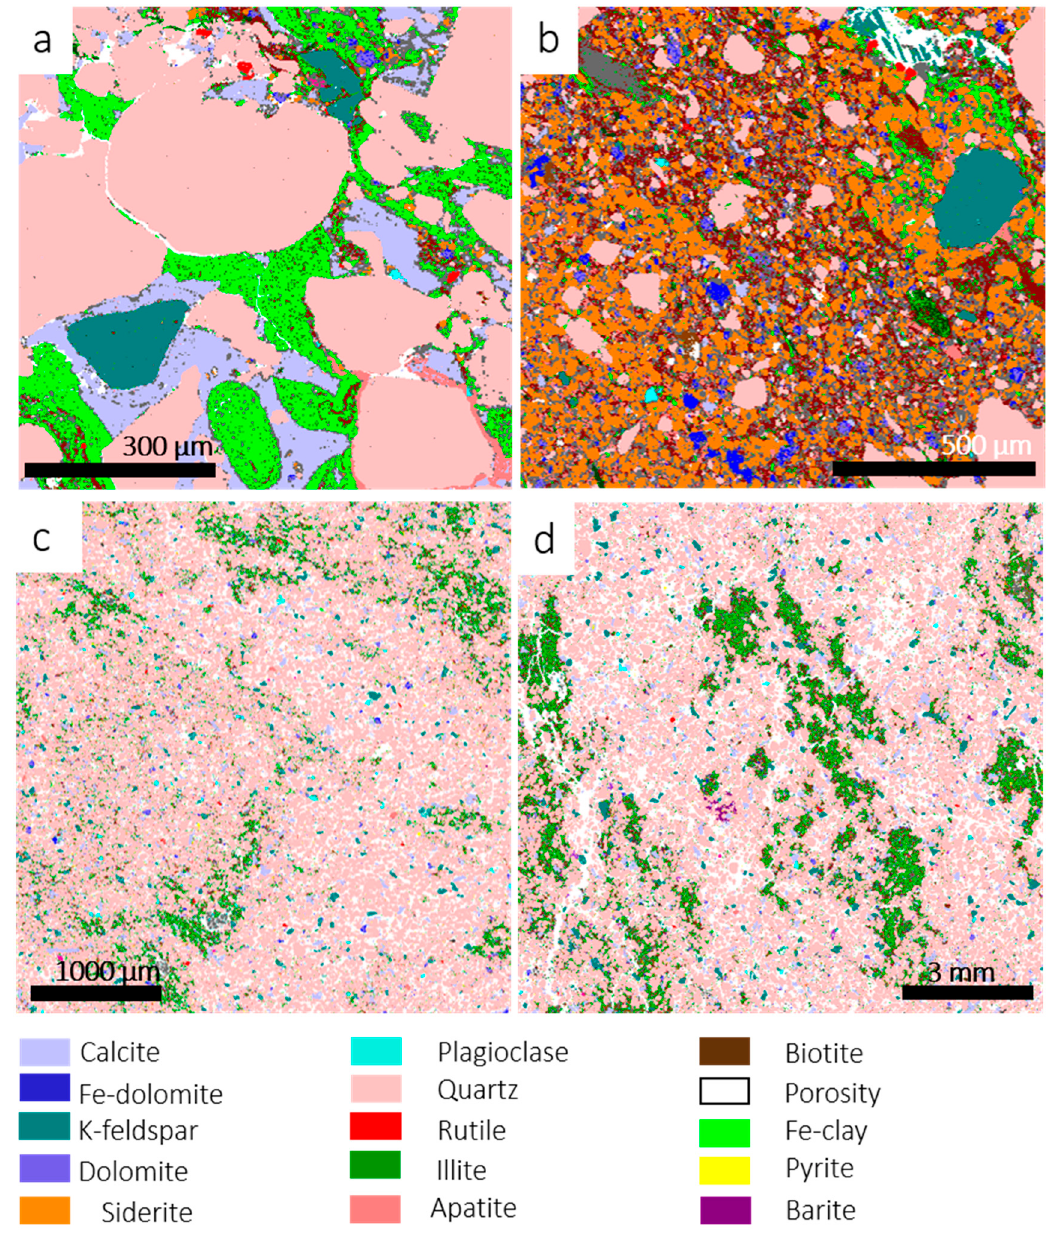
Figure 9. ( a ) BL5 (2199.9 m MD) at 2 μ m resolution: SEM-EDS porosity (1.67%) shows dissolved K-feldspar with the former grain boundaries outlined where calcite cement has filled the dissolved grain portion (bottom-left). Pore-filling apatite is seen at the bottom-right lining a quartz grain. ( b ) Same sample as Figure 9a, non-bioturbated upper shoreface sandstones. Siderite matrix occupies most of the image truncated by Fe-dolomite and detrital biotite. The top-right shows moldic porosity from a dissolved K-feldspar grain. ( c ) BL5 (2208.0 m MD): SEM-EDS porosity 19.7%, core porosity 21.6, permeability 5.7 mD, sandstone sampled from a zone homogenised by bioturbation. ( d ) PW7 (1135.7 m MD) at 20 μ m resolution: core porosity 29.6% showing microfractures.